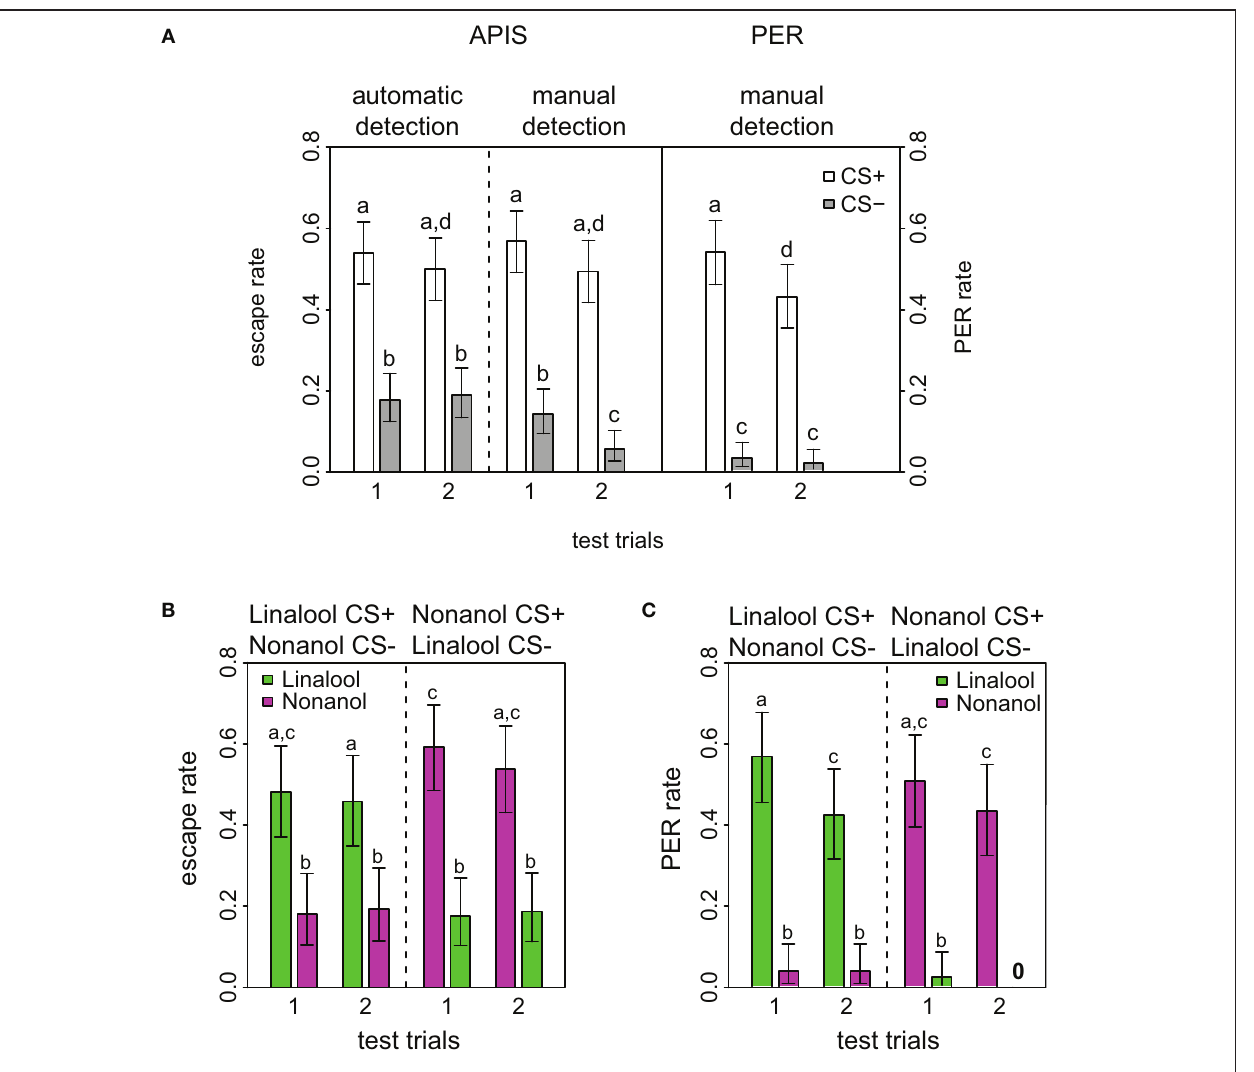
FIGURE 2 | Response rates in APIS and PER during short-term memory test. (A) Observed response rates for APIS (left) and PER (right) during the four stimuli of the test trials. The left part of the figure depicts the high similarity between the automatically detected (far left) and the manually observed escapes (middle). Response rates to the CS + are equal in both systems. Note as well the higher generalization levels for APIS, and the prominent extinction rate for PER. Error bars are 95% confidence interval. Groups that are significantly different ( p < 0 . 05, by either proportion test or McNemar test) are indicated by different letters above the bars ( N = 174 and 162 bees for APIS and PER, respectively). (B) Observed escape responses